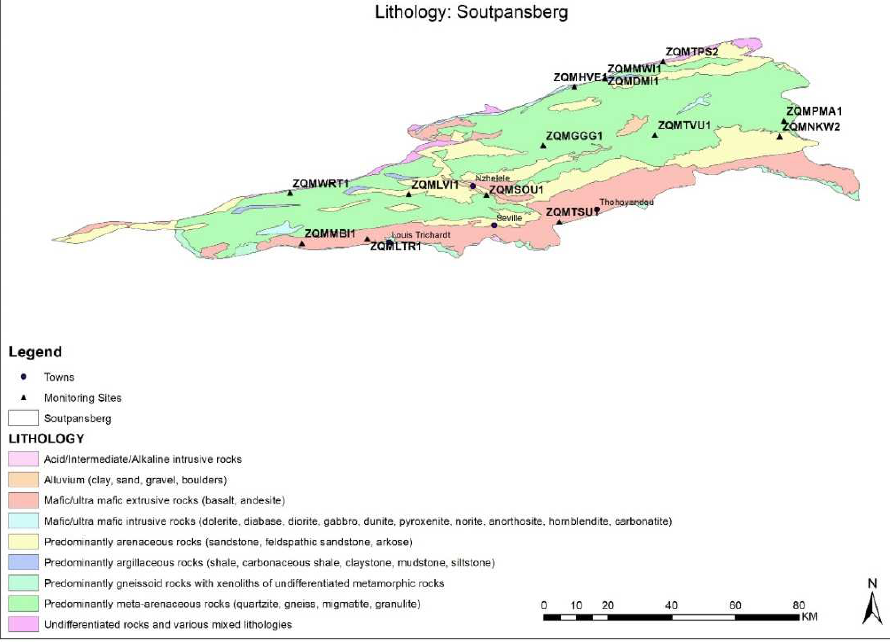
Figure 2. Lithological settings of the Soutpansberg region.